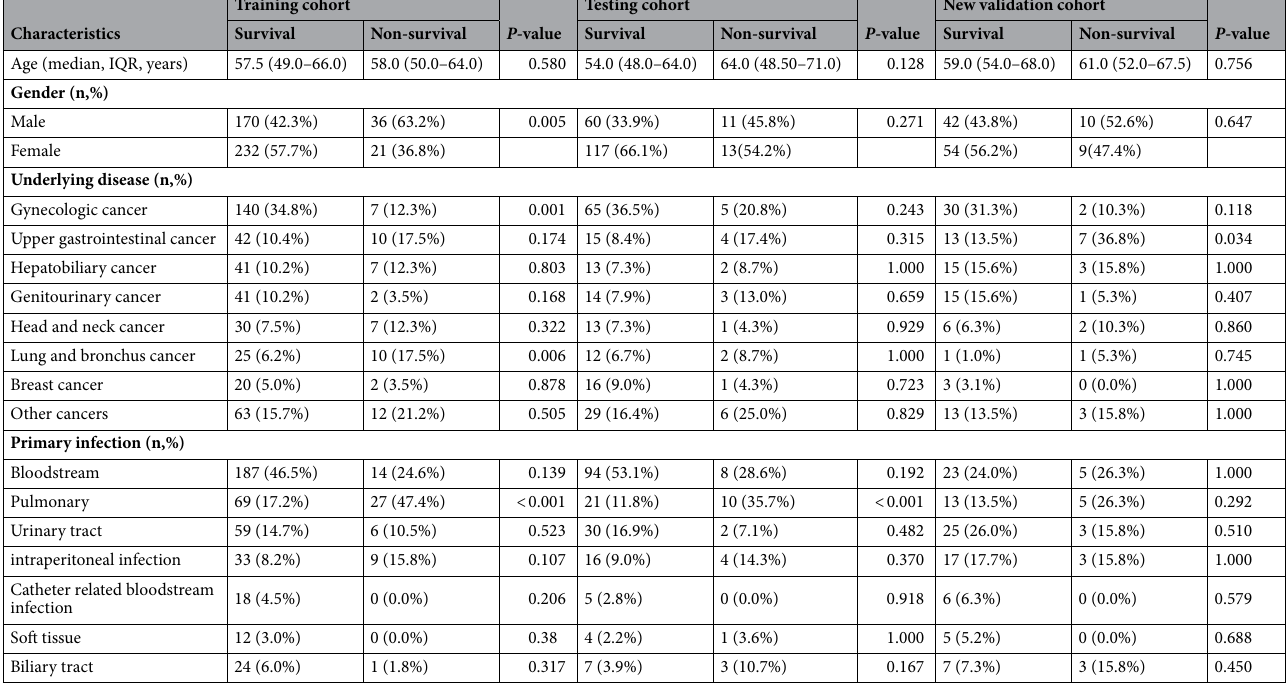
Table 2. Characteristics of training and validation